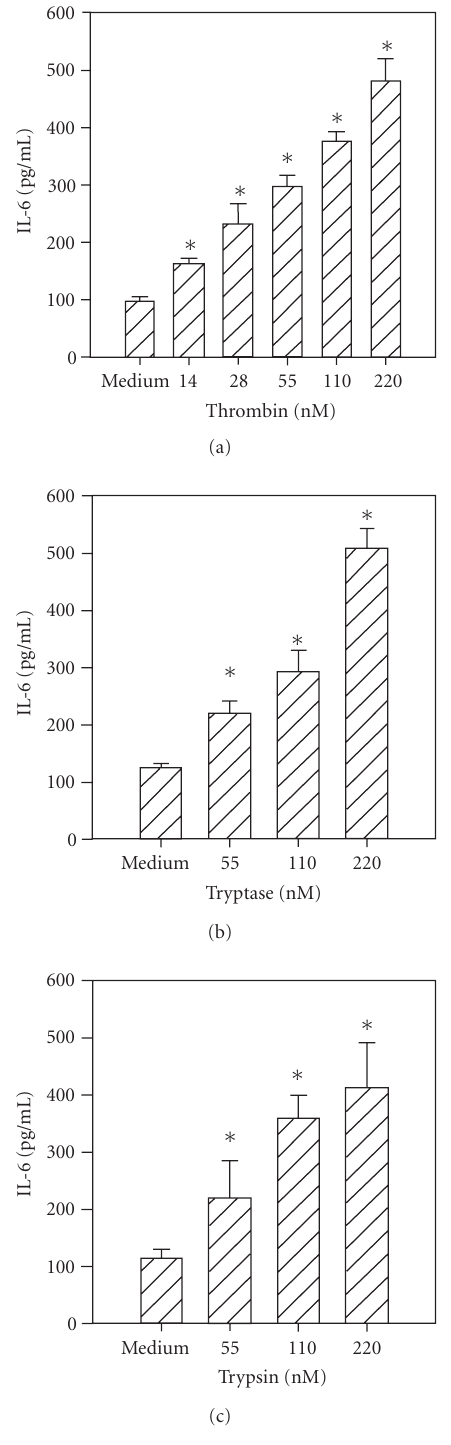
Figure 2: Thrombin-, tryptase-, and trypsin-stimulated IL-6 produc- tion by HCECs . HCEC monolayers were incubated with the indi- cated concentrations of thrombin (a), tryptase (b), or trypsin (c). After a 24-hour culture, IL-6 levels in the culture media were as- sayed by ELISA. Each value presented is the mean + / − SD of qua- druplicate determinations. The results presented are representatives of four independent experiments. ∗ indicates P < .05 when compared to medium control.